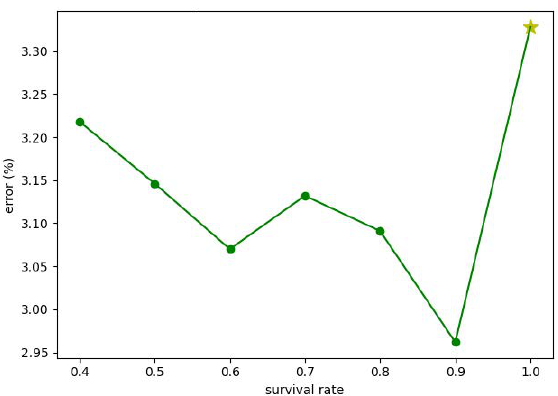
Figure 7. The performance of the proposed method with different survival rates.